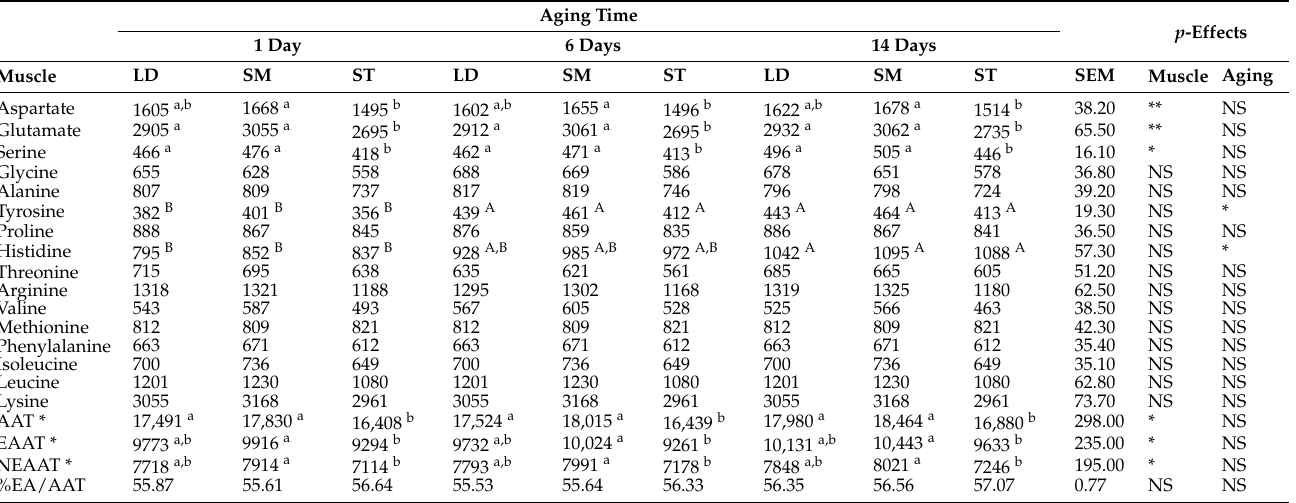
Table 4. Effect of muscle and aging time (days) on amino acids content (mg/100g of meat) of meat from horse (means ± SEM).